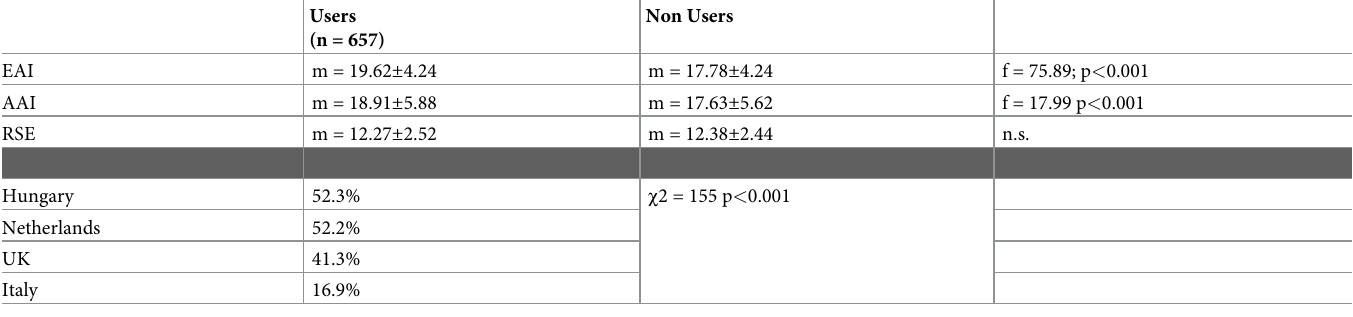
Table 4. Fitness supplements users vs non-users: Differences considering to Exercise Addiction Inventory, Appearance Anxiety Inventory, Rosenberg Self-Esteem and their country. Users (n =